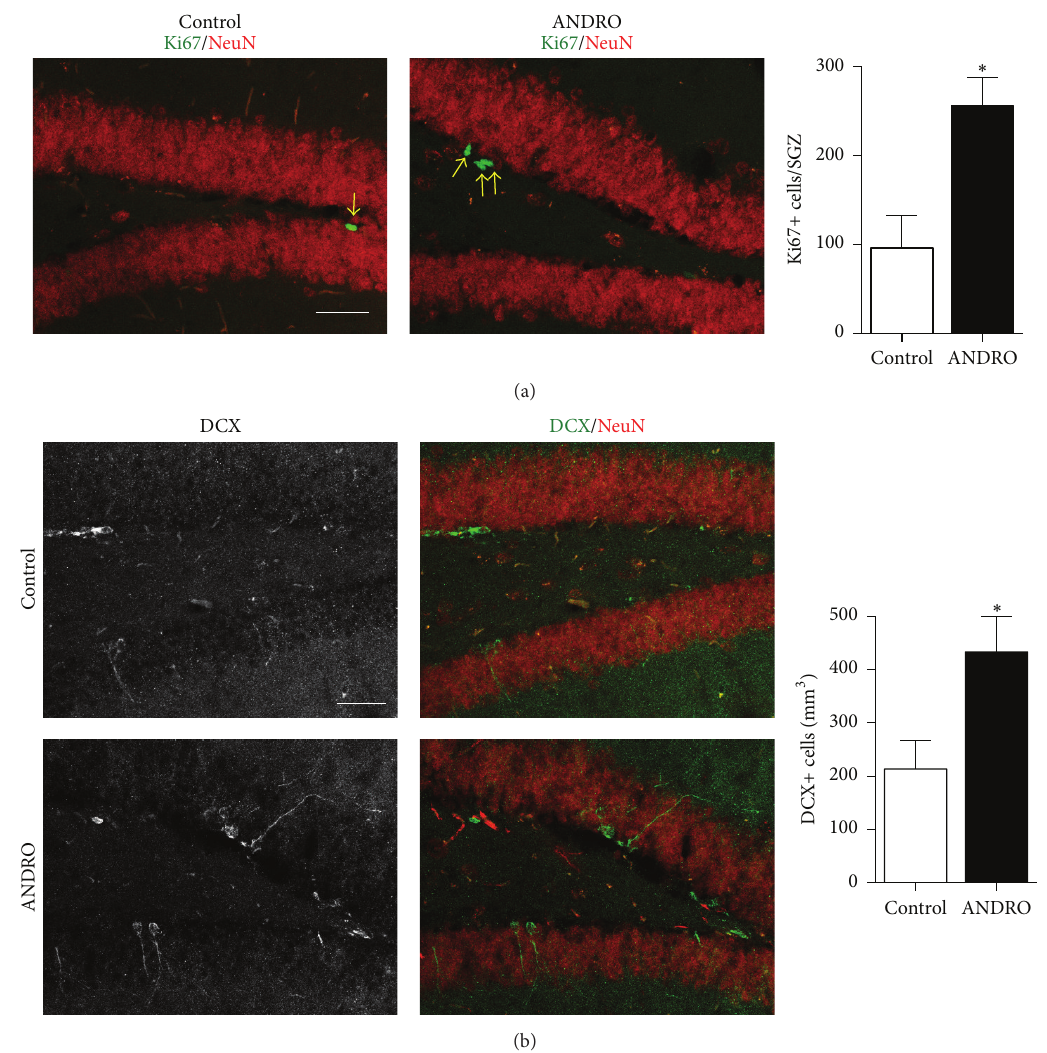
Figure 6: ANDRO stimulates proliferation and the density of immature neurons in the dentate gyrus of APPswe/PSEN1 Δ E9. Seven-month- old APPswe/PSEN1 Δ E9 mice were injected i.p. with 2 mg kg −1 ANDRO or vehicle as control 3 times a week per 4 weeks. (a) Representative images of double immunostaining for Ki67 and NeuN. The graph shows quantification of the total number of Ki67-positive (Ki67+) cells (yellow arrows) in the SGZ of mice treated with vehicle or ANDRO. Scale bar: 20 𝜇 m. (b) Images show representative double immunostaining for DCX and NeuN. Scale bar: 20 𝜇 m. Graph differences in the density of immature DCX-positive (DCX+) neurons in control and ANDRO- treated APPswe/PSEN1 Δ E9 mice. Bars represent mean ± S.E. ( 𝑛 = 3 (a) or 𝑛 = 5 (b) mice). ∗ 𝑃 < 0.05 , Student’s 𝑡